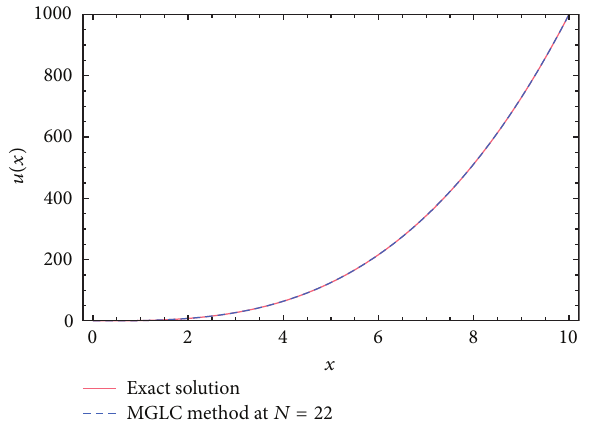
Figure 2: Graph of exact solution and approximate solution for 𝛼 = 2 , 𝛽 = 1 at 𝑁 = 22 for Example 2.